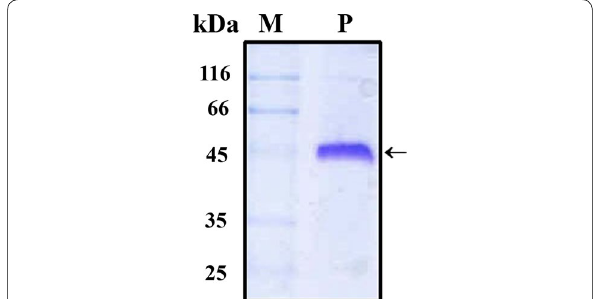
Fig. 1 SDS-PAGE (12%) analysis of purified rLTB.Etx 40–62 . Lane P shows the purified rLTB.Etx